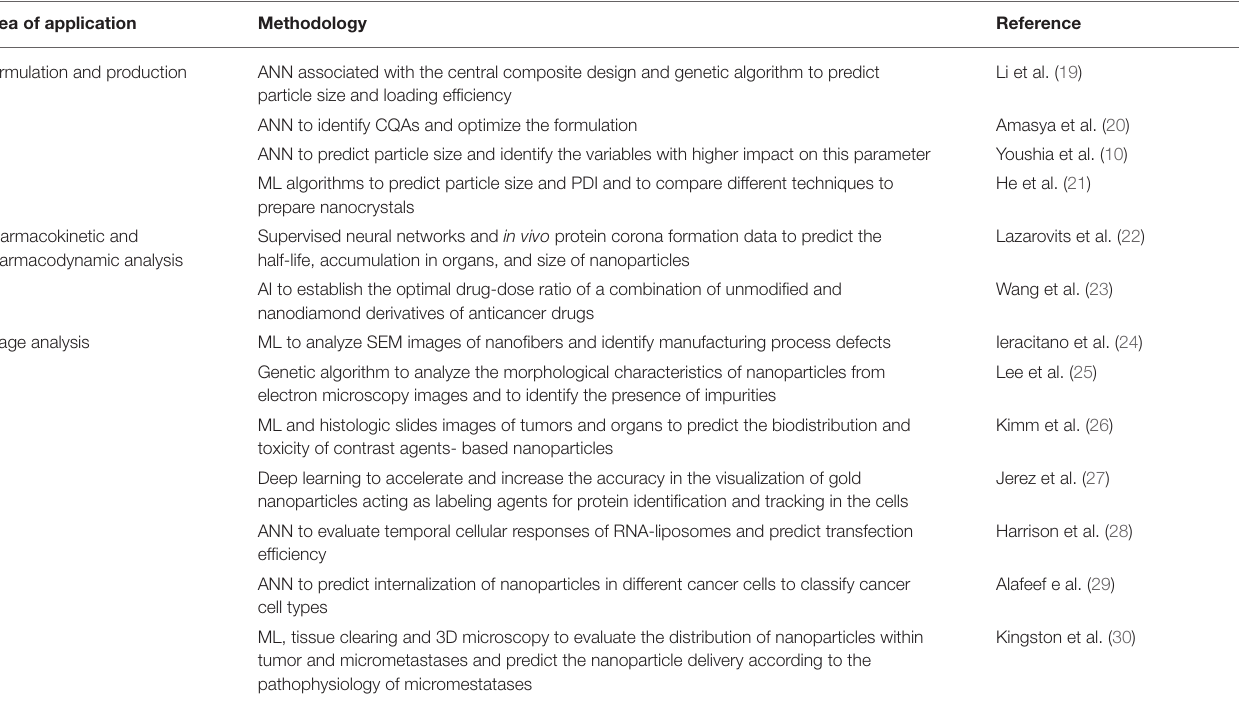
TABLE 1 | Selection of studies involving the application of AI in the development of